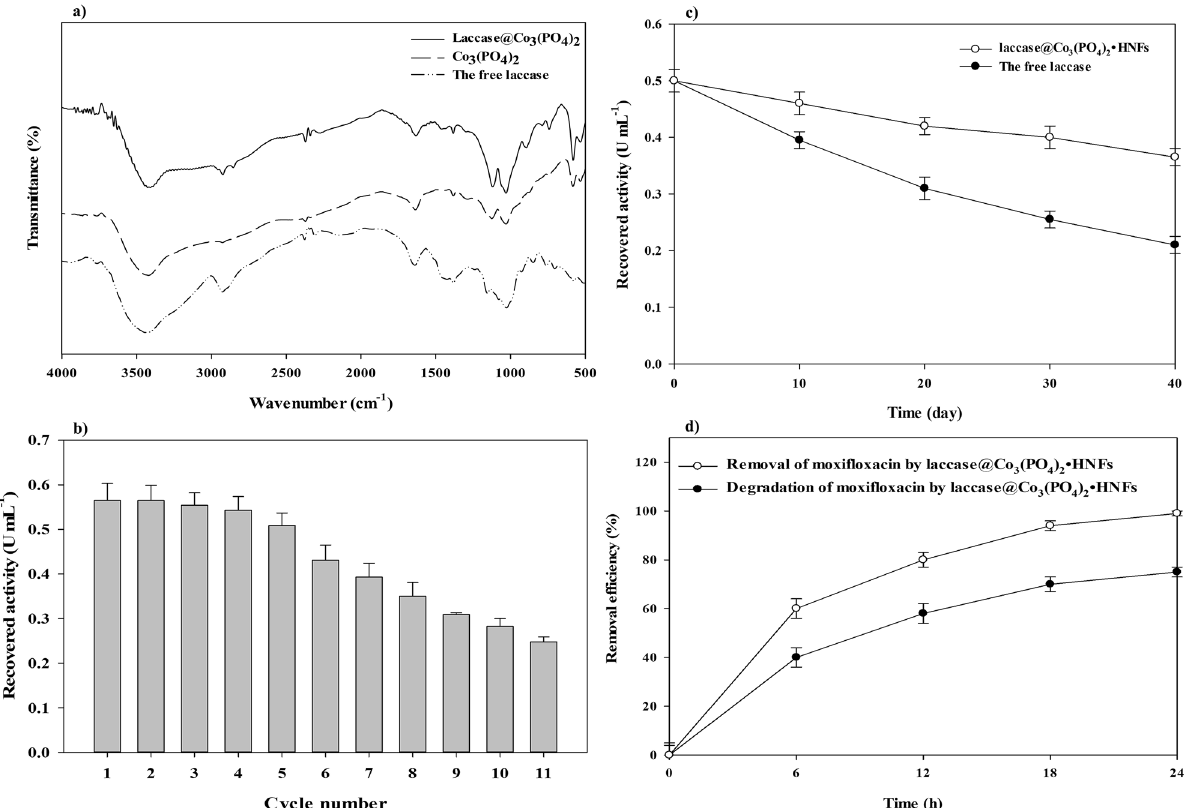
Figure 4. FT-IR analysis. The spectra of Fourier transform infrared (FTIR) spectroscopy of laccase@ Co